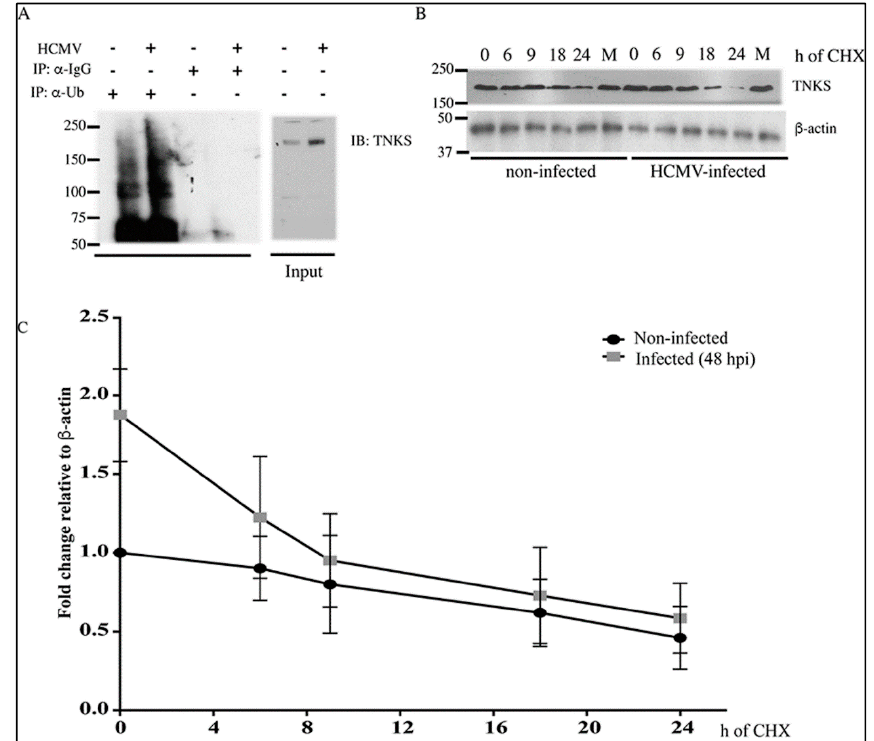
Figure 2. TNKS degradation is not inhibited upon HCMV infection. ( A ) Western blot showing ubiquitination of TNKS immunoprecipitated from non-infected and HCMV-infected HFFs using an anti-ubiquitin antibody. HFFs were infected with HCMV Towne at MOI = 1 and harvested at 72 hpi; ( B ) Western blot showing stability of TNKS after 48 h of infection at MOI = 3 followed by treatment with cycloheximide to inhibit de novo translation and harvested at indicated time points. M indicates treatment with MG132 as a proteasome inhibitor control; ( C ) Quantification of TNKS’ degradation normalized to β -actin from ( B ) Cycloheximide was added at 48 hpi for the times indicated in the X axis (h of CHX). Data shown are the average of three experiments with standard error of the means.